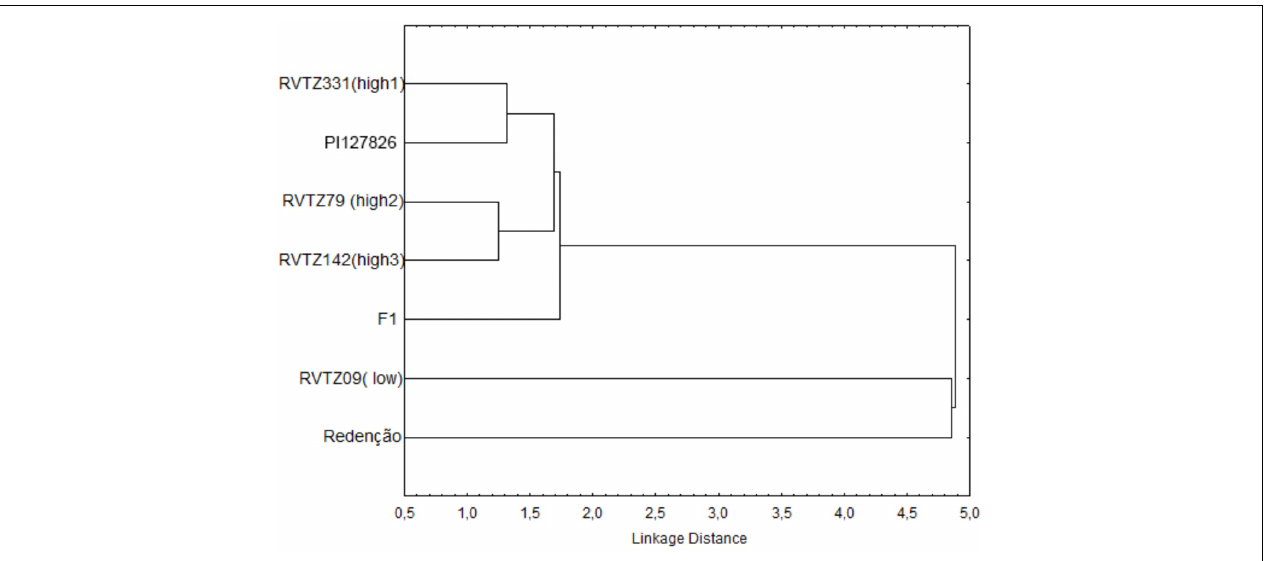
FIGURE 3 | Relationships (dendrogram) between seven tomato genotypes with different contents of zingiberene using hierarchical cluster analysis (Linkage’s method). The cladogram has been based on number and type of trichomes, zingiberene content, and behavioral and biological parameters of Tetranychus